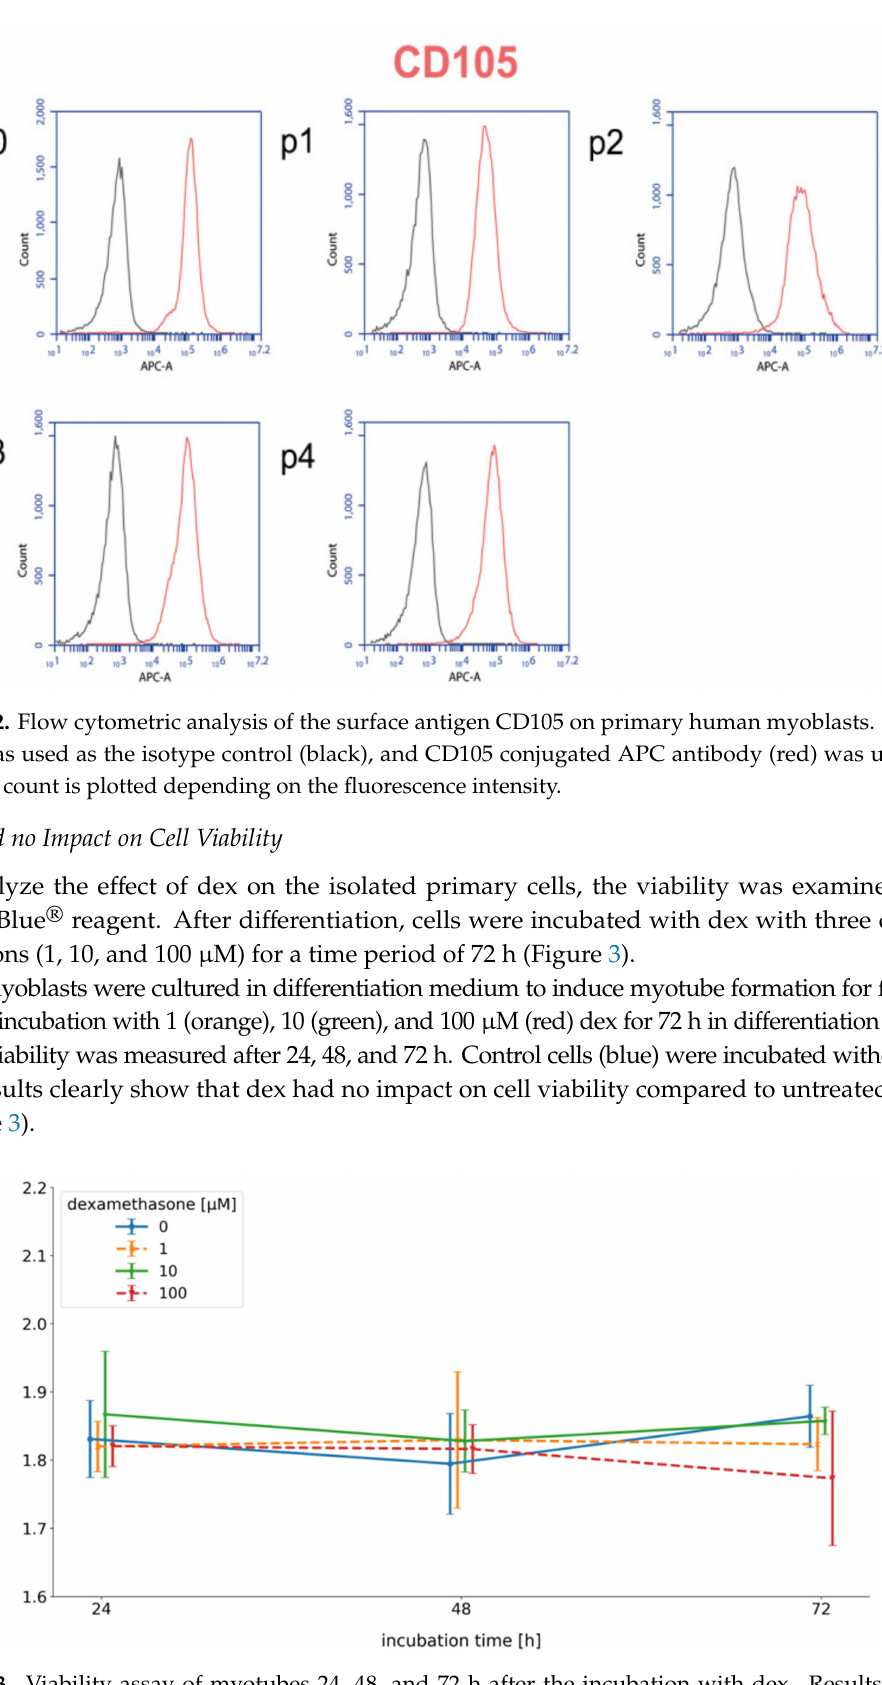
Figure 3. Viability assay of myotubes 24, 48, and 72 h after the incubation with dex. Results are represented in a line diagram and error bars show the standard deviation ( n =